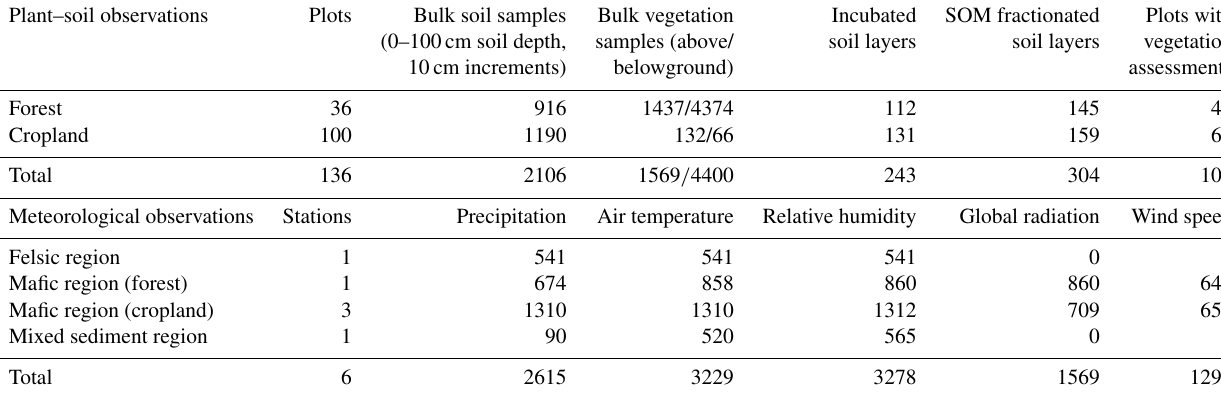
Table 2. Overview of the current number of data points in TropSOC v1.0 on plant, soil, and meteorology and their affiliation to the hierar- chical levels of forest and cropland. Numbers in tables refer to the number of data entries at the lowest available aggregation level ( = highest resolution of data). For details on parameters, see the corresponding metadata descriptions. Note that collected weather station data in the felsic (Uganda) and mixed sediment region (Rwanda) represent both cropland and forest, while separate stations were available for the two land cover classes in the mafic region (DRC). Abbreviations: SOM = soil organic